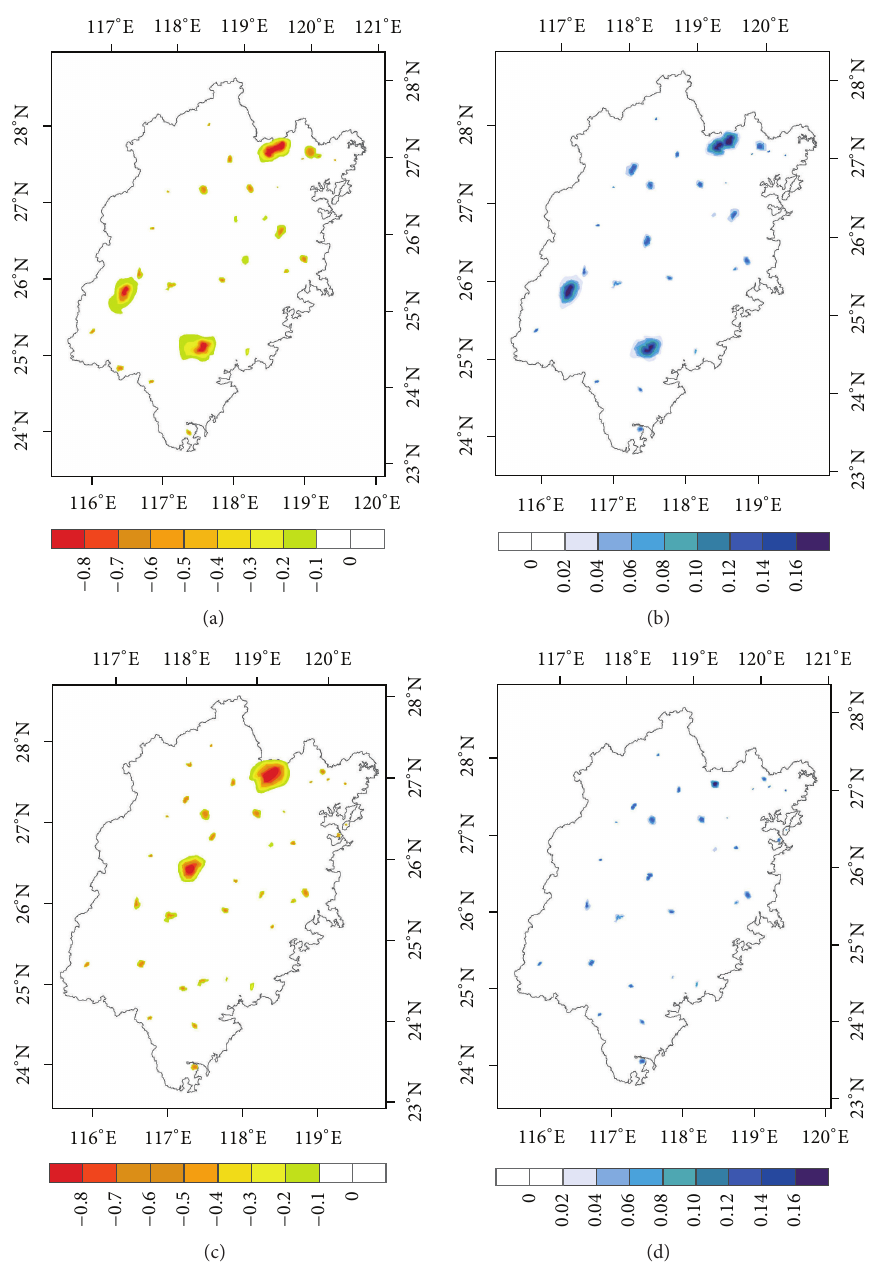
Figure 6: Seasonal average near-surface temperature at 2 meters height (unit: ∘ C) change in 2010–2050. (a) Summer temperature change under RCP6 scenario; (b) winter temperature change under RCP6 scenario; (c) summer temperature change under RCP8.5 scenario; (d) winter temperature change under RCP8.5